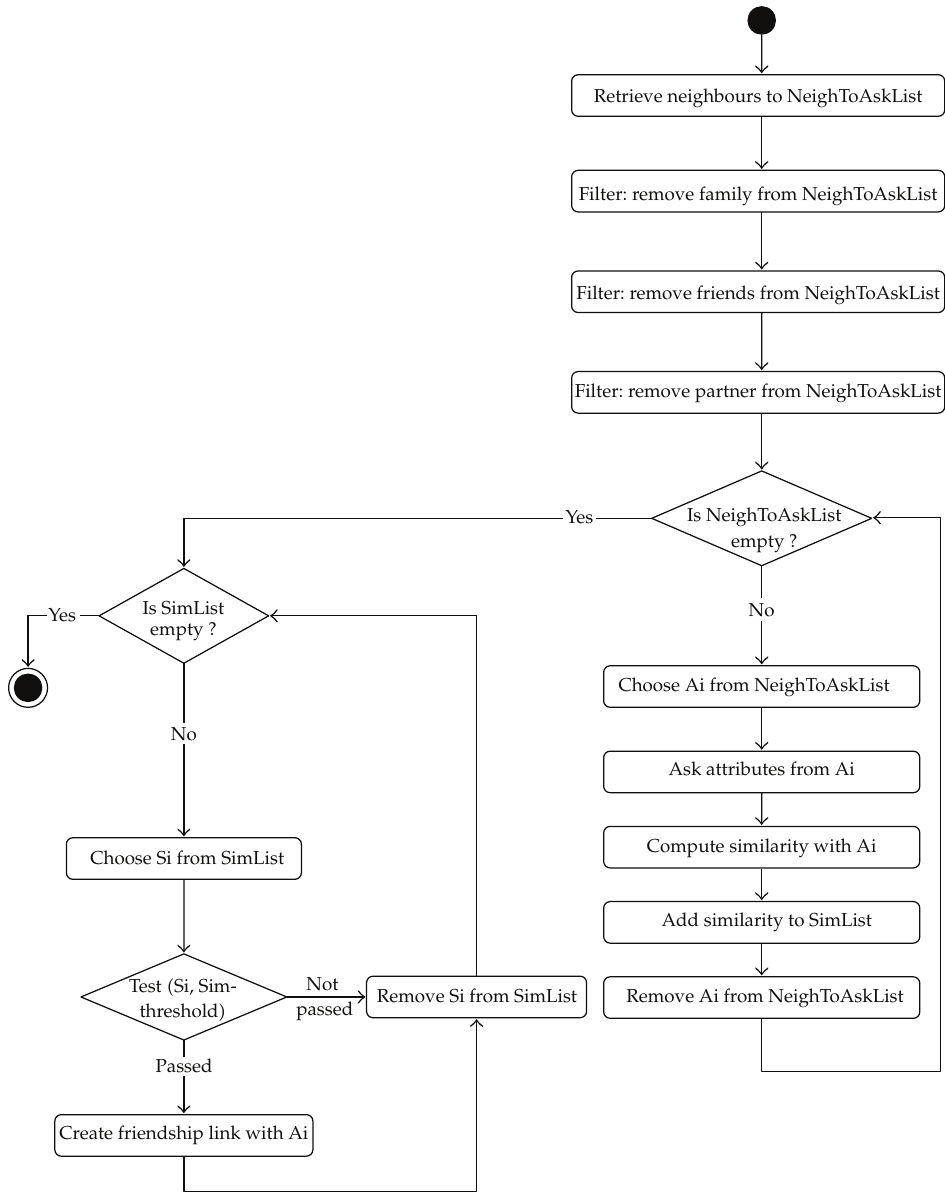
Figure 1: Flow diagram summarising the process of emergence of a friendship